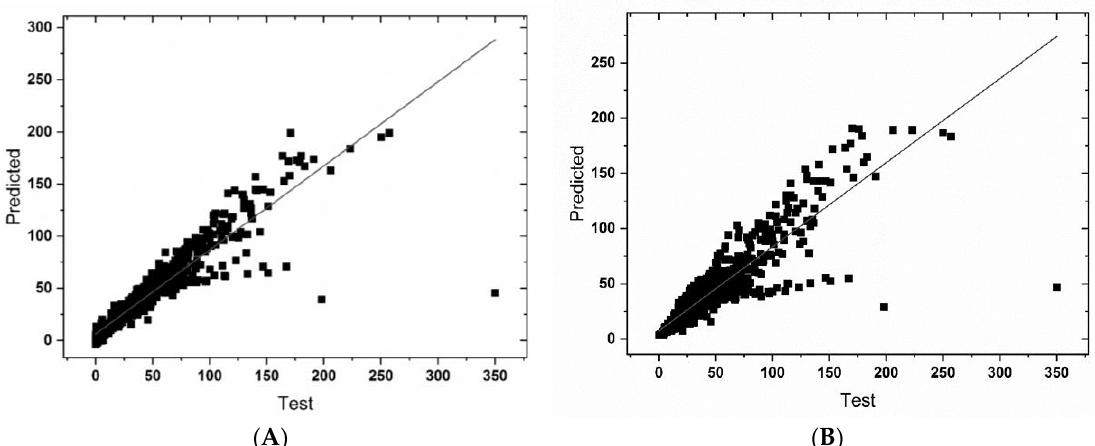
Figure 2. Plot of multiple linear regression ML model prediction for test data compared with the actual values.